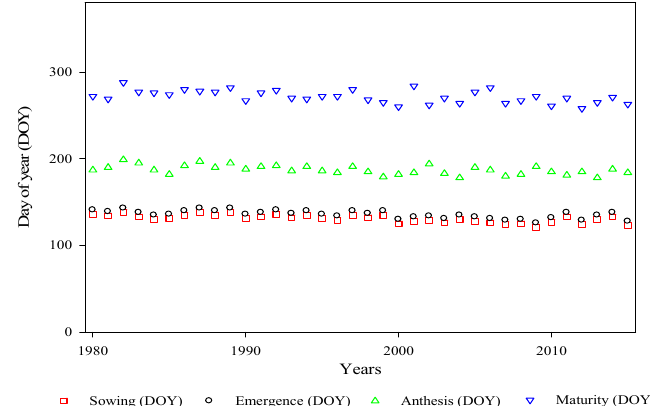
Figure 4. Time series plots of observed dates of onset of phenological stages (sowing, emergence, anthesis and maturity) for cotton from 1980 to 2015 in Punjab, Pakistan.